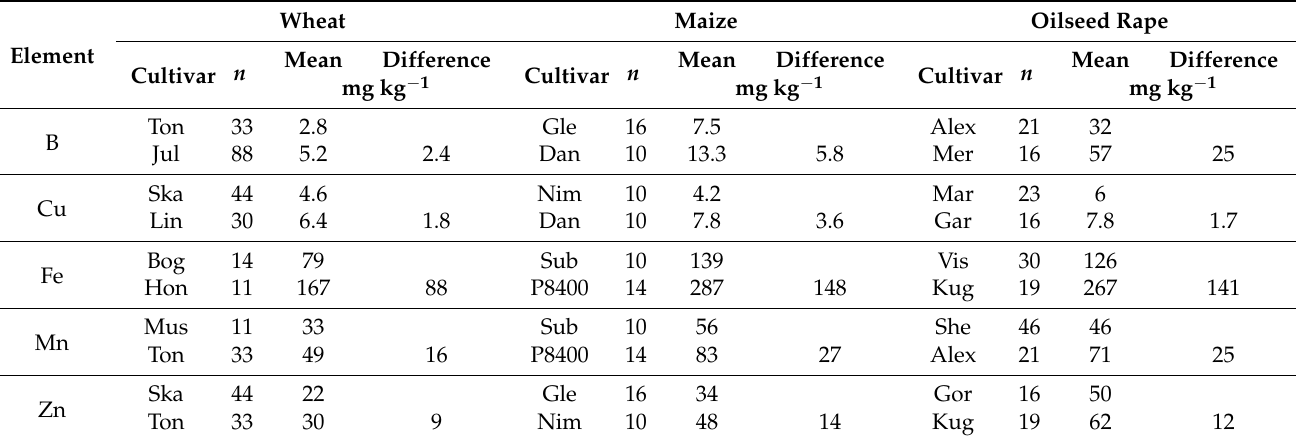
Table 5. Differences among cultivars in the concentration of micronutrients in shoots—based on cultivars with the lowest and highest mean concentration.